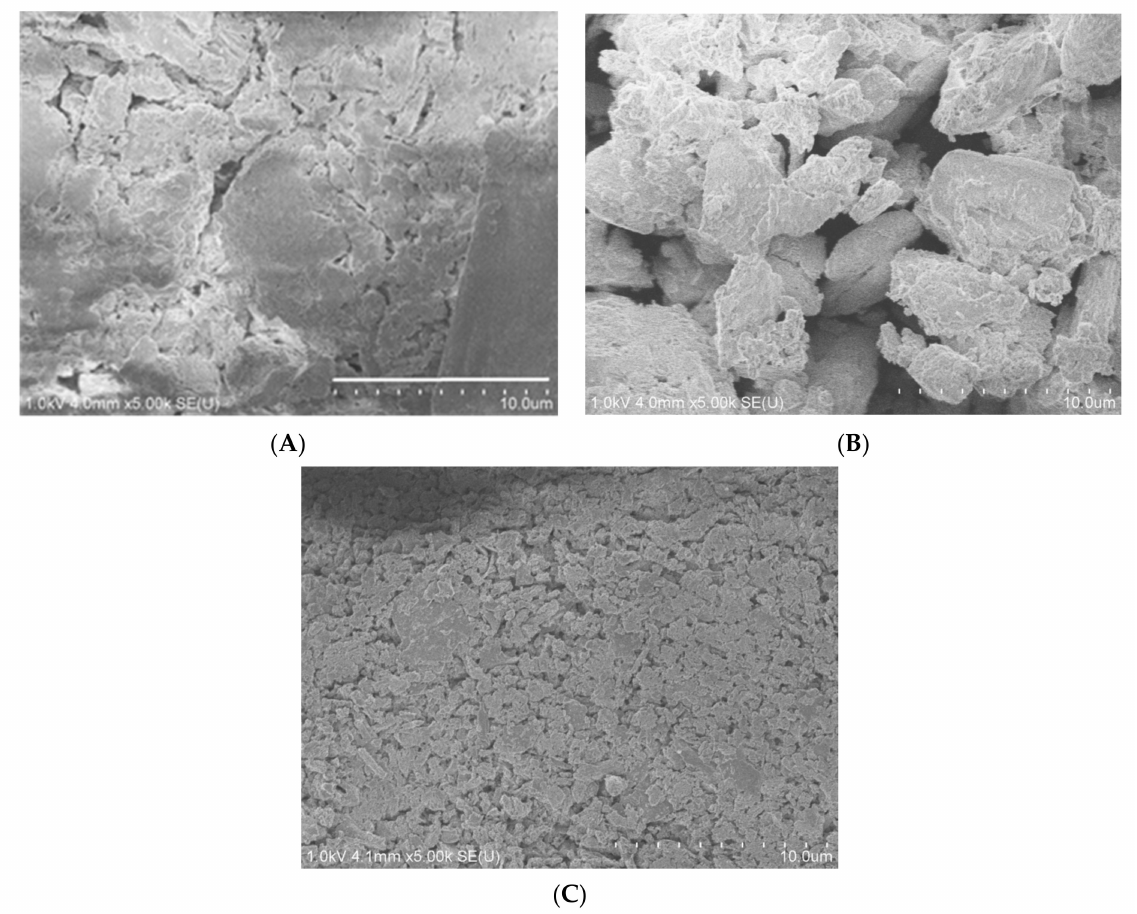
Figure 1. SEM images of as-prepared exfoliated g-C 3 N 4 powder ( A ), settled part of the ultrasonication (US)-treated exfoliated g-C 3 N 4 suspension after one-week sedimentation ( B ), stable part of suspension after one-week sedimentation ( C ). The scale is the same for all images (10 µ m), and in image ( A ), the scale is highlighted by the white